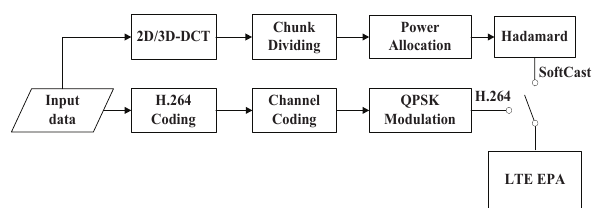
Figure 6: Performance evaluation for varying chan- nel SNRs.